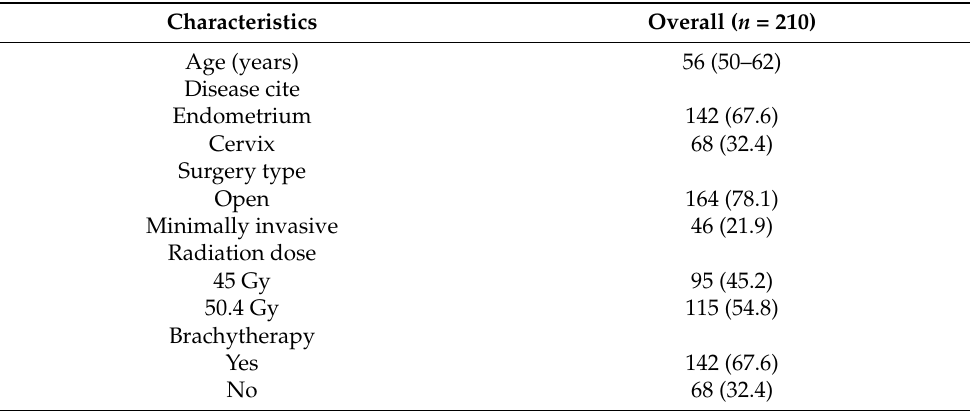
Table 1. Patient and tumor